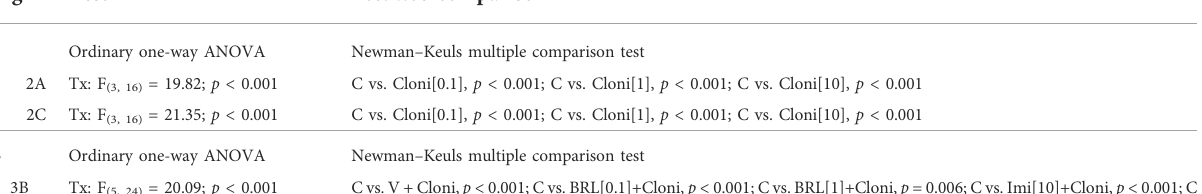
TABLE 3 Ordinary one-way or two-way repeated-measures analysis of variance (ANOVA) with their respective post hoc comparison for each fi gure. Fig Test Post hoc